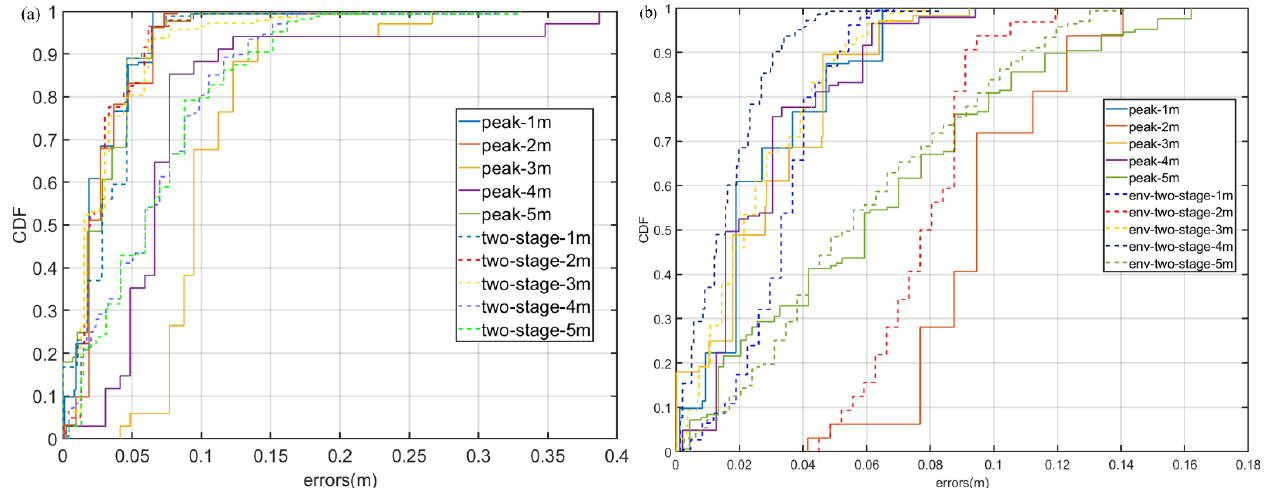
Figure 24. CDF in Case 1. ( a ) Comparison results between Peak and two-stage. ( b ) Comparison results between Peak and env-two-stage.